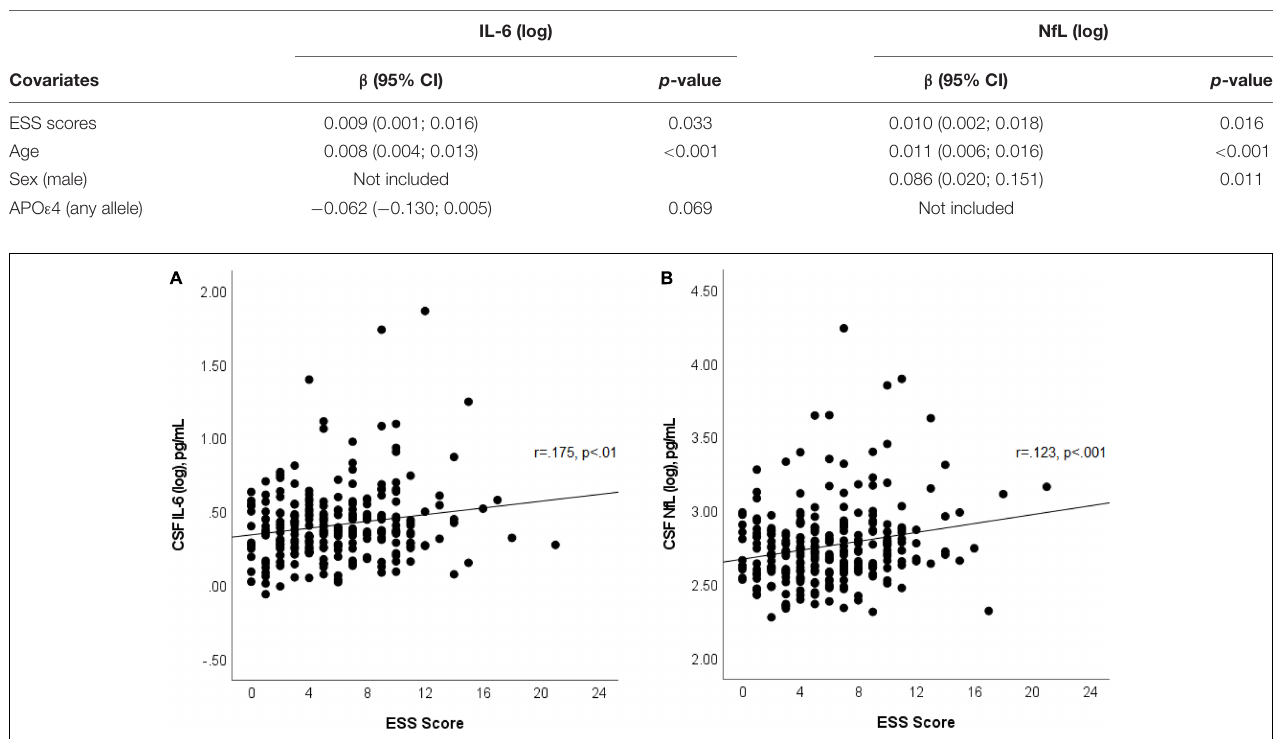
TABLE 2 | Estimates for final linear regression models after backward selection procedure.